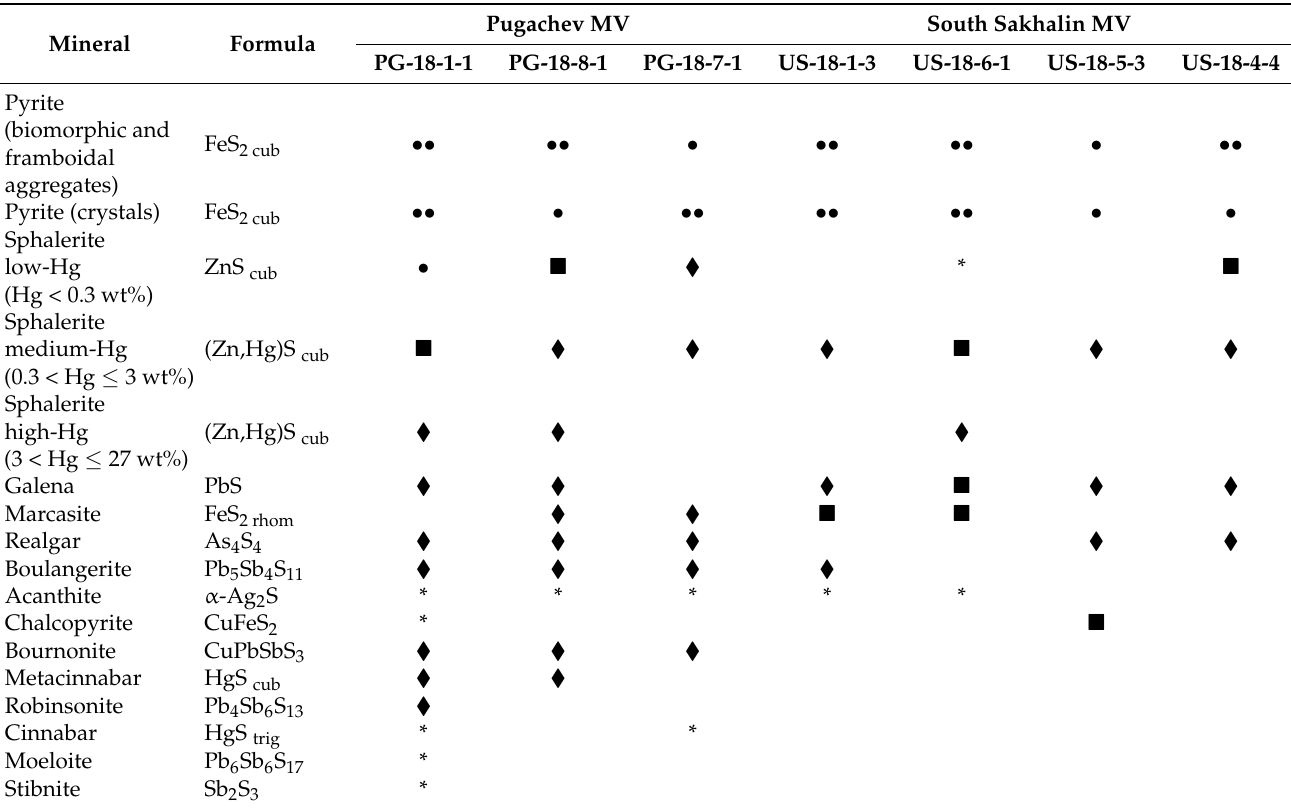
The contents of Co, Ni, Mo, Cd, and Tl are lower than the respective upper continental crust (UCC) values in bulk mud samples but correspond to the UCC reference in the heavy fractions (Table 3). Other chalcophile elements (Zn, Hg, As, Ge, Se, and Cu) occur in moderate amounts in bulk mud masses but are high in the heavy fractions. In the heavy fraction mud samples from Pugachev MV, the excess relative to the UCC values reaches two orders of magnitude for Hg and Se, around ten times for Zn, Sb, As and Ge, and ~1.5 times for Bi, Pb and